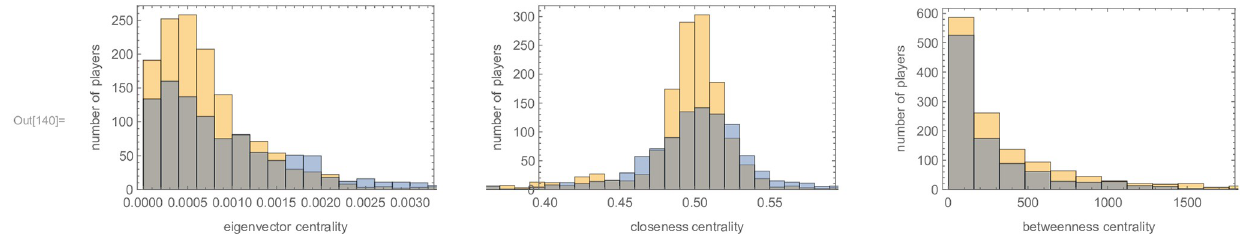
Fig 6. Histograms of the eigenvector centrality (EC), closeness centrality (CC), and betweenness centrality (BC) for the baseball and basketball- Twitter networks shown left, center, and right, respectively. Baseball is shown in orange and basketball is shown in blue in each